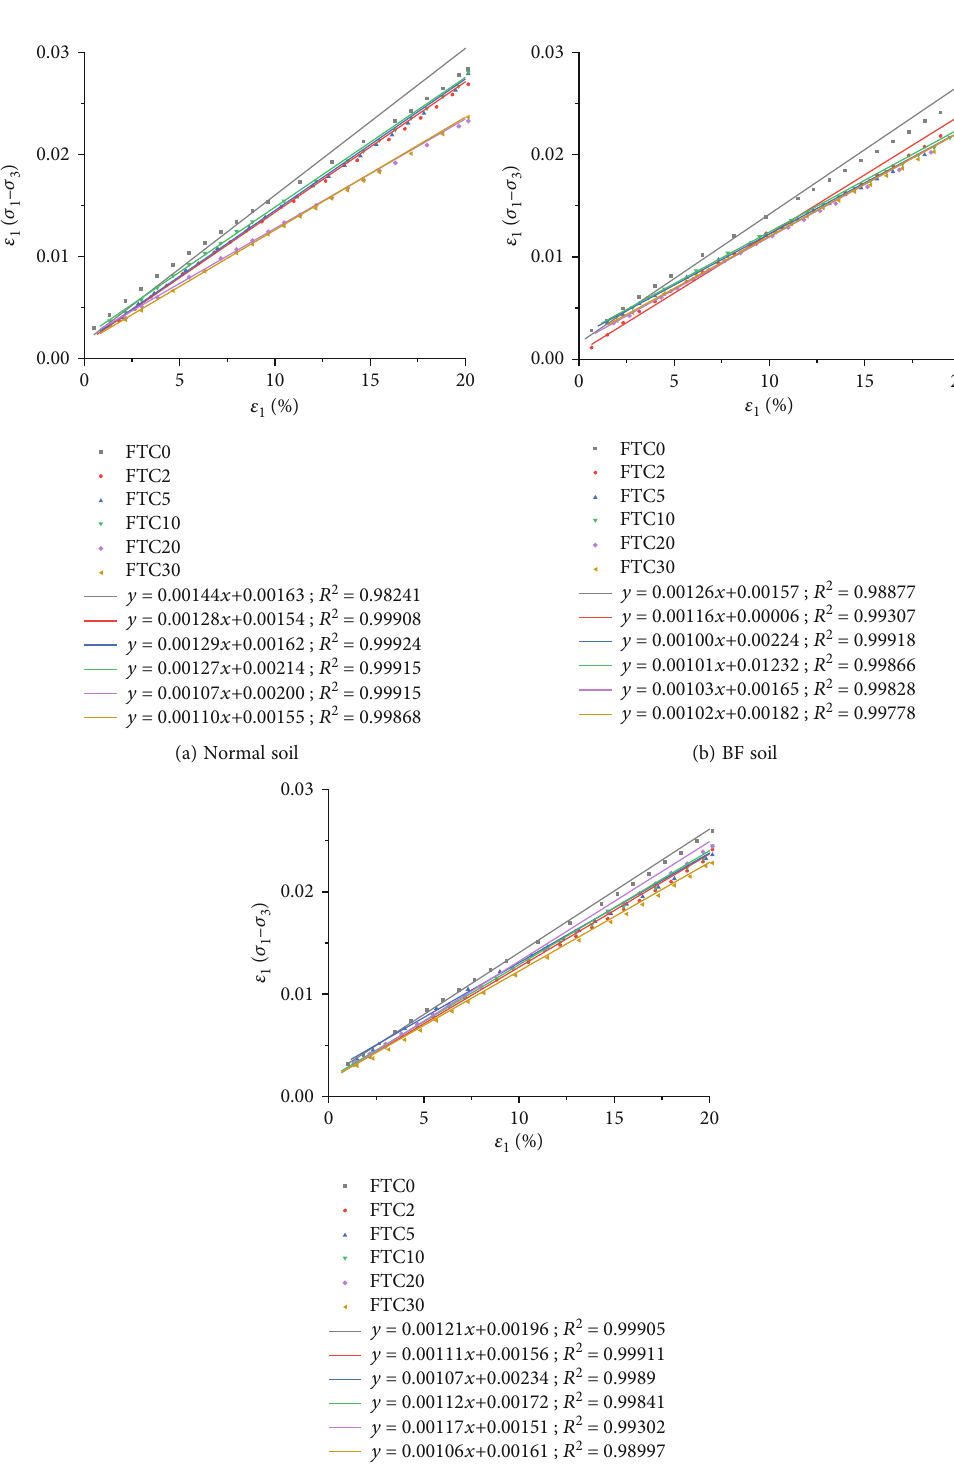
Figure 12: Hyperbolic fi